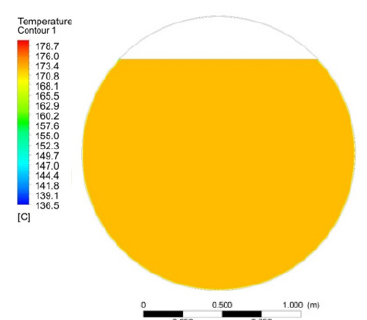
Figure 1. Thermal field of the liquid with the viscosity of 0.01 Pa · s after 60 h.